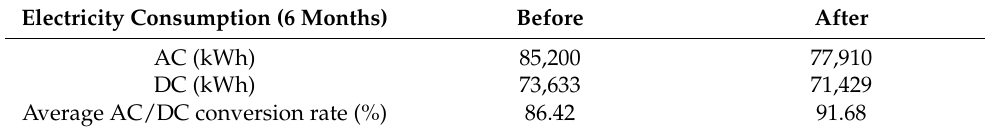
Table 9. The AC and DC power before and after upgrade.